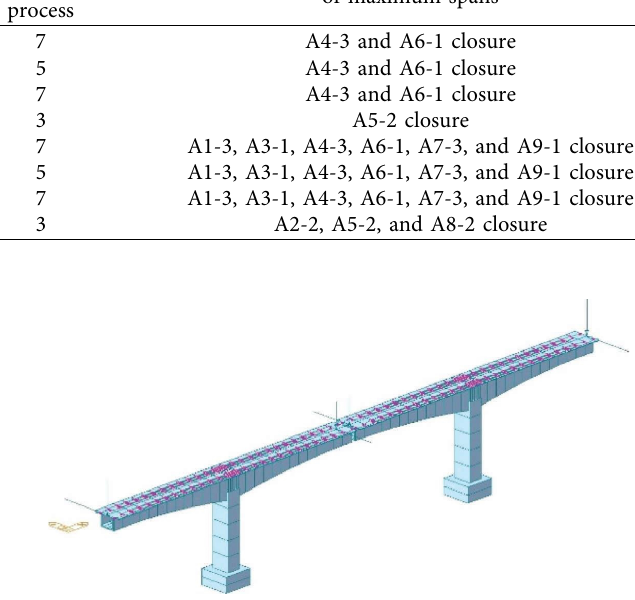
Figure 3: Phase VIII construction. Table 2: Material characteristics of prestressed